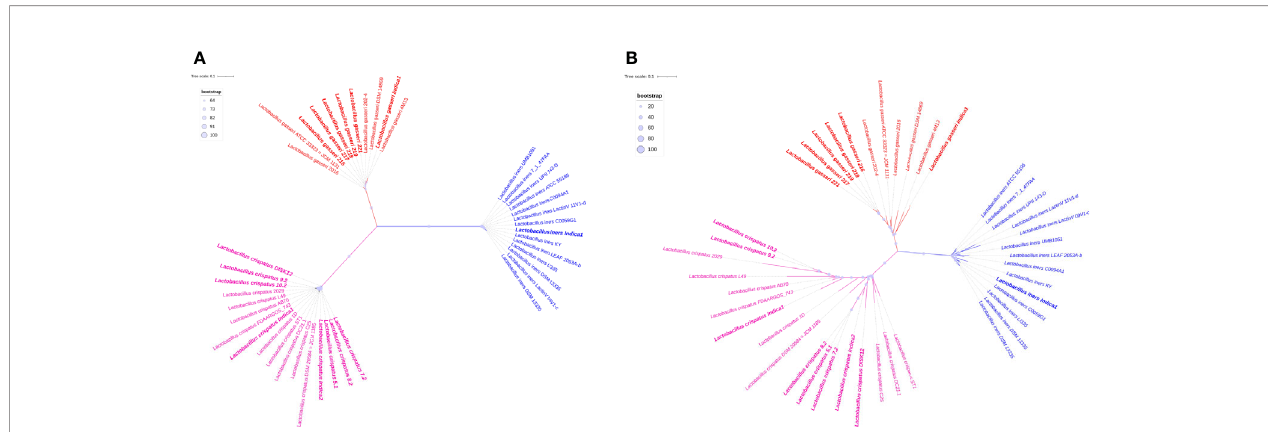
FIGURE 5 | Pan- and core-genome based unrooted phylogenetic trees. (A) Core-genome based phylogeny. (B) Pan-genome based phylogeny. All three clades of phylogeny have been shown red, green and blue colors. Branch length of each leaf has not shown in number but it is proportional to divergence from last common ancestor. Bootstrap values of pan genome based phylogeny have range to ≥ 20 to 100. In case of core genome, boot strap value range to ≥ 64 to 100. It has been shown in light blue circle. The radius of the circle ranges from 5 to 15 pixels in both phylogeny trees. Indian strains of Lactobacillus have been shown in bold.